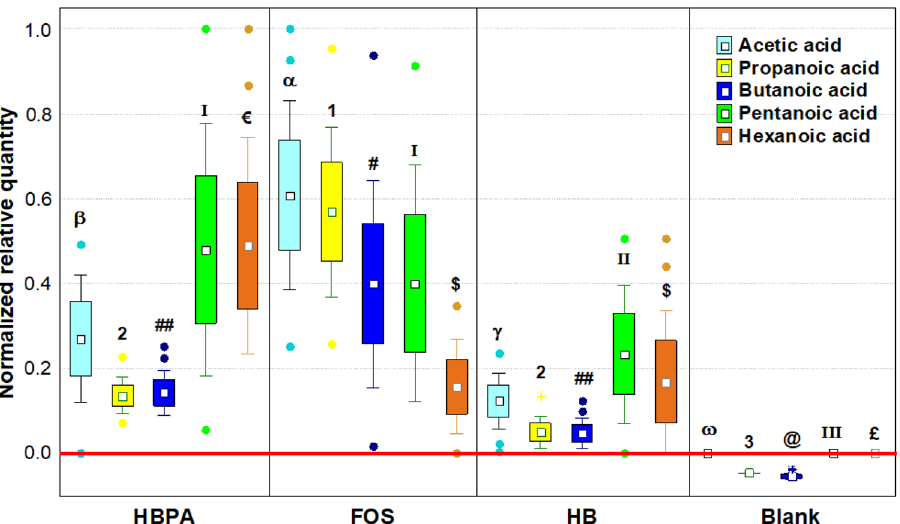
Figure 2. Changes in the abundance of beneficial microbial VOCs metabolites, expressed as normalized scale from relative abundances with respect to the baseline (red line). The baseline absolute quantifications in mg/kg are found in the Supplementary Material (Table S3). Changes were recorded after 6, 18, and 24 h of in vitro fecal batch fermentations with HBPA, HB, FOS, and a blank control. Each plot is made with the raw data obtained from each time point and replica. Samples were analyzed in duplicate from two independent experiments ( n = 4). Marker = mean; box = mean ± S.D.; whiskers = non outlier range; dots = outliers; asterisks = extremes. Cases with different letters or numbers or symbols among a single independent variable are significantly different according to Tukey’s HSD test ( p < 0.05). HB Hempseed bran; HBPA HB protein extract hydrolyzed by alcalase; FOS fructooligosaccharides; Blank Blank control.